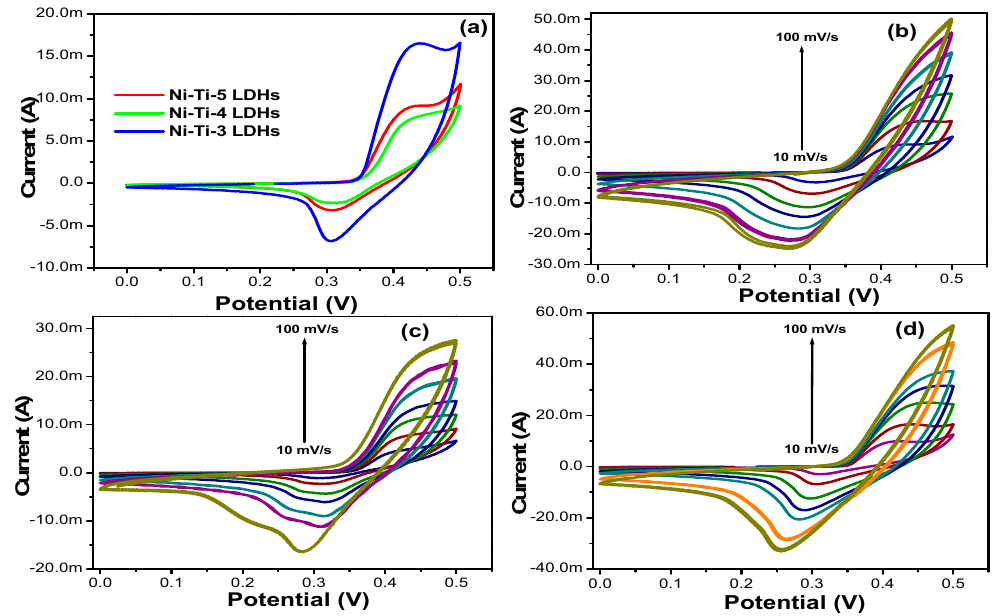
Figure 10. ( a ) Comparative CV curves of all the LDHs ( b ) CV curve of the Ni-Ti-5 LDHs ( c ) CV curve of the Ni-Ti-4 LDHs, and ( d ) CV curve of the Ni-Ti-3 LDHs at different scan rate.